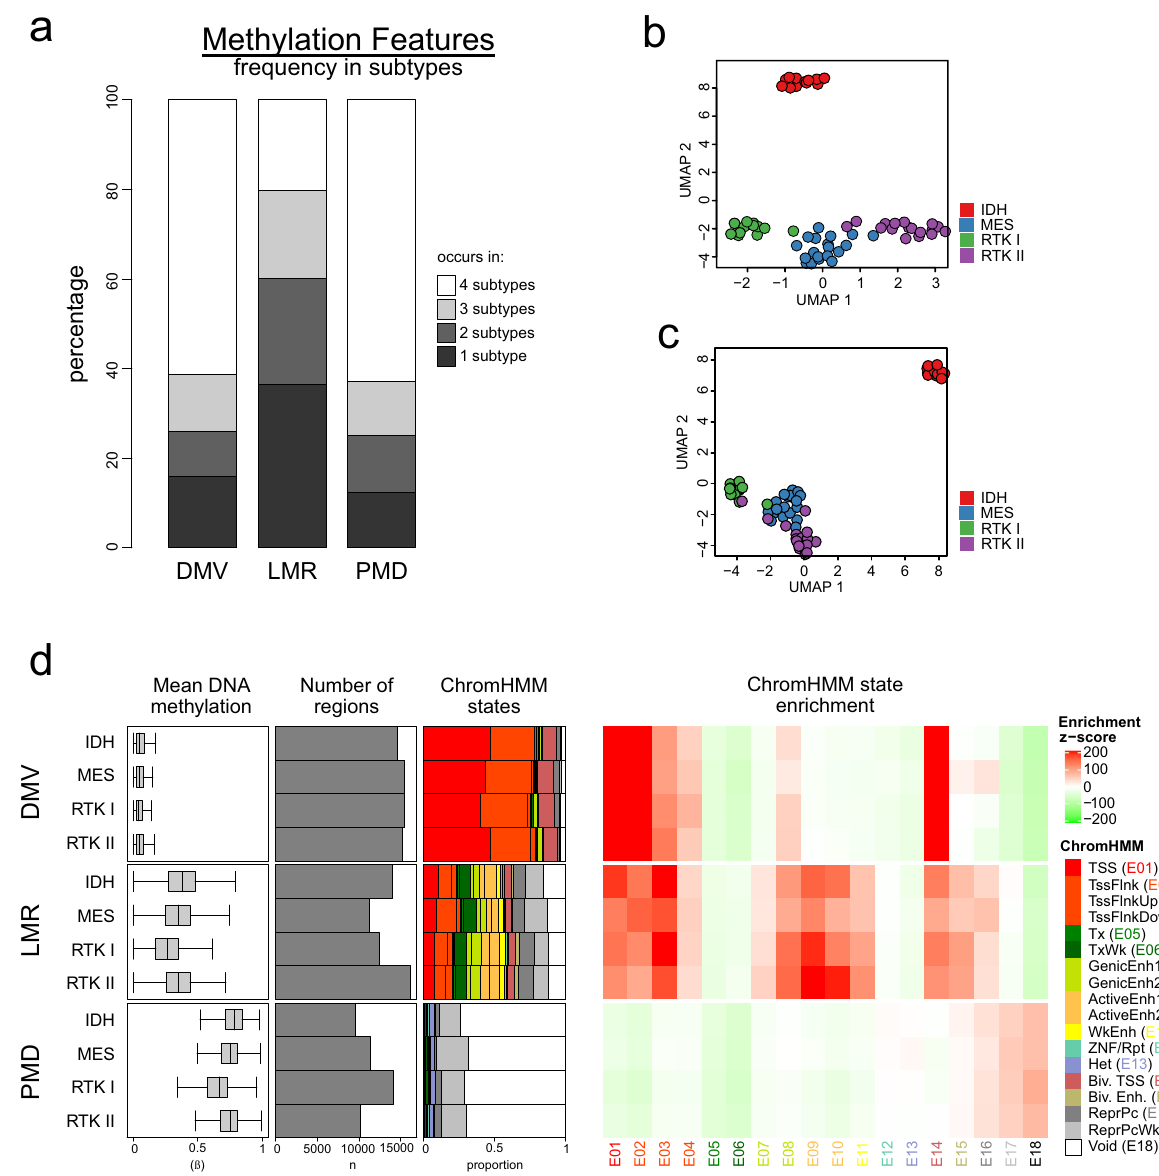
Fig. 2 Active enhancer-LMR regions show highly variable methylation across glioblastoma subtypes. a Barplots showing the extent of subtype sharing of DNA methylation valleys (DMVs, left), lowly methylated regions (LMRs, middle) and partially methylated domains (PMDs, right). b Uniform manifold approximation and projection (UMAP) plot of the study glioblastoma samples based on the analysis of DNA methylation in LMRs. c UMAP plot of the glioblastoma samples based on the analysis of DNA methylation at enhancers. d Summary statistics for subtype DMVs, LMRs and PMDs, showing (left- right): mean DNA methylation (WGBS beta; boxes correspond to the 25th, 50th/median and 75th percentiles; whiskers denote 1.5× the IQR from the median); number of regions; ChromHMM state annotation; and ChromHMM state enrichment (see Methods for details of enrichment statistic calculation) for each subtype ’ s feature set. IDH, n = 12; MES, n = 19; RTK I, n = 12; RTK II, n = 17